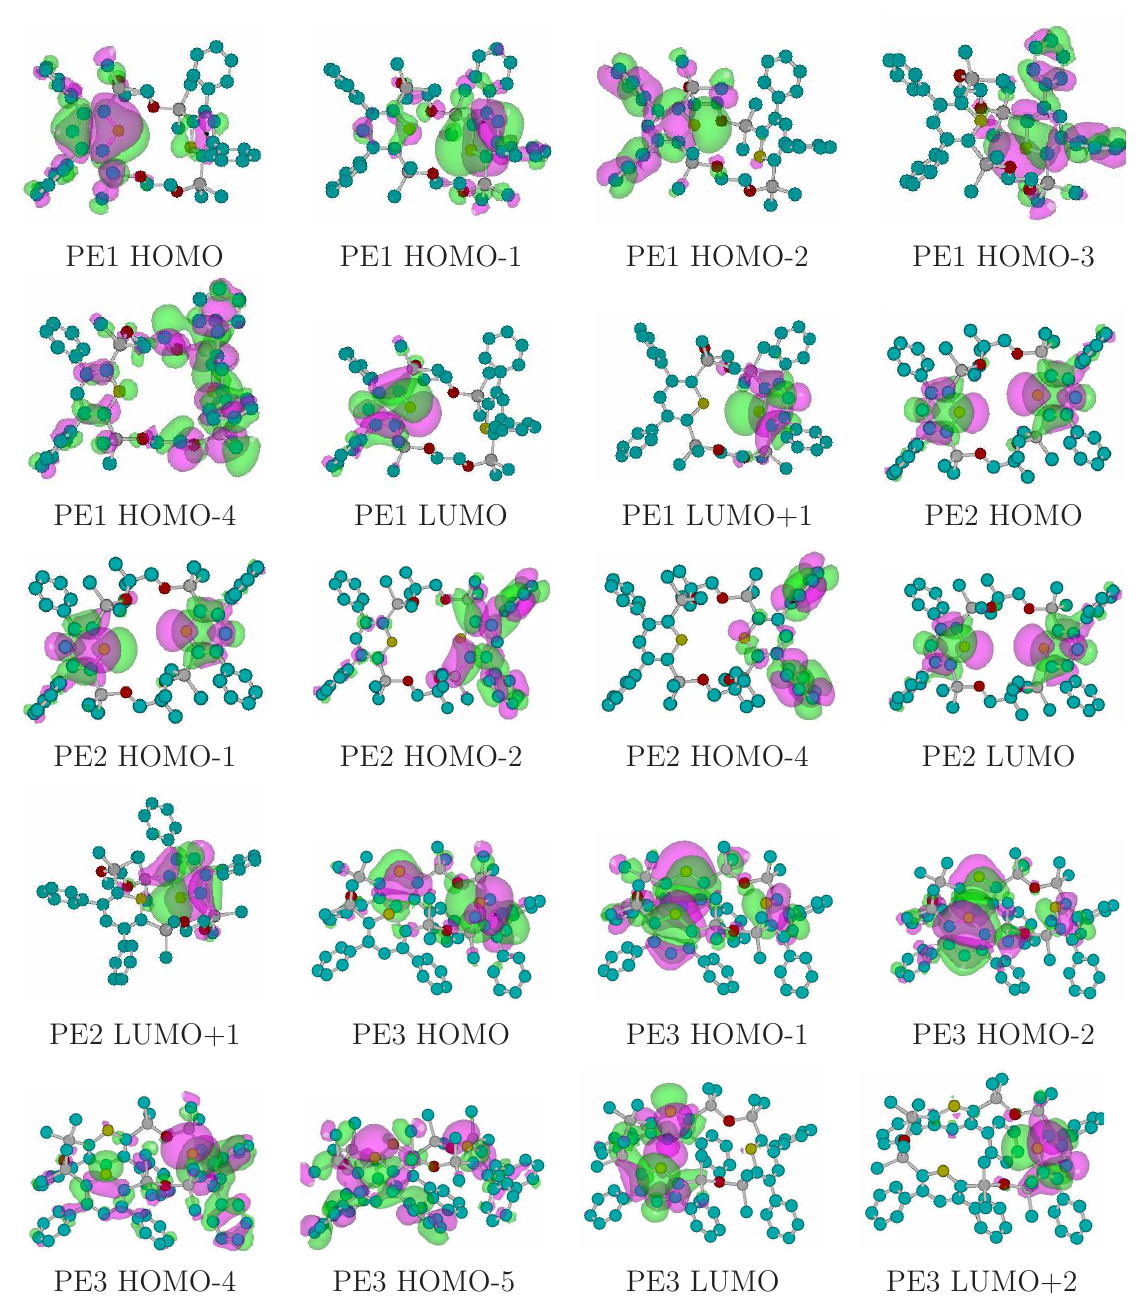
Fig. 4 Frontier orbitals of phosphinine-ether macrocycles from the PM3 calculation